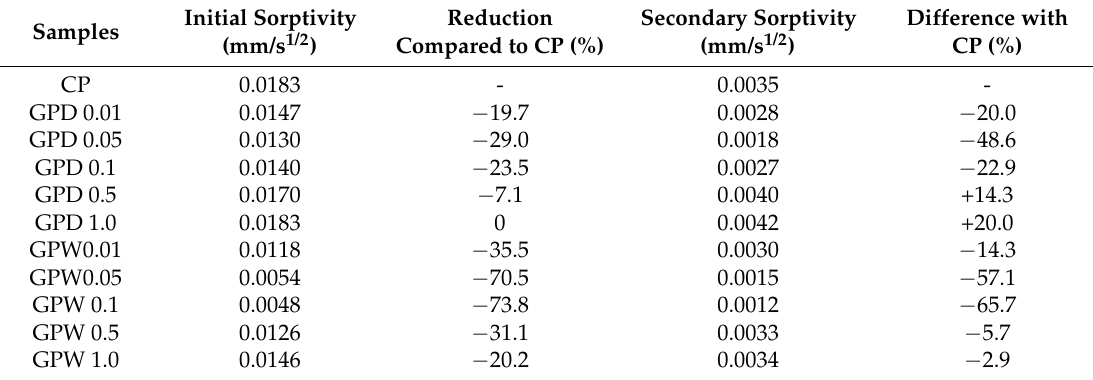
Table 4. Initial and secondary sorptivity of cement paste mixes for dry and wet-mix design